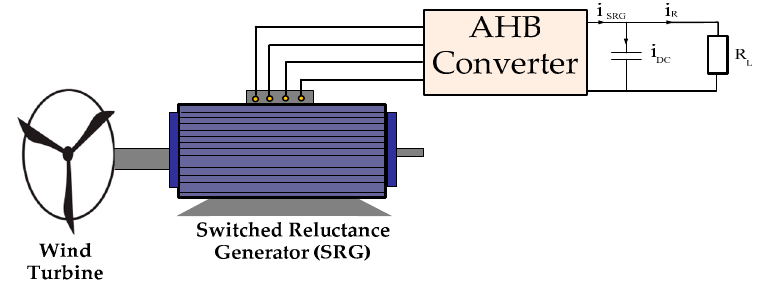
Figure 1. An overview of the system under study.